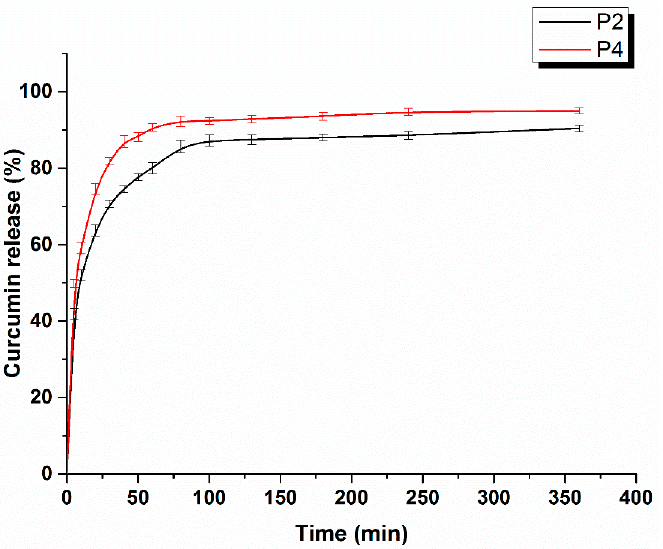
Figure 7. Curcumin release profile for P2 and P4 samples ( n = 3; error bars = SD).